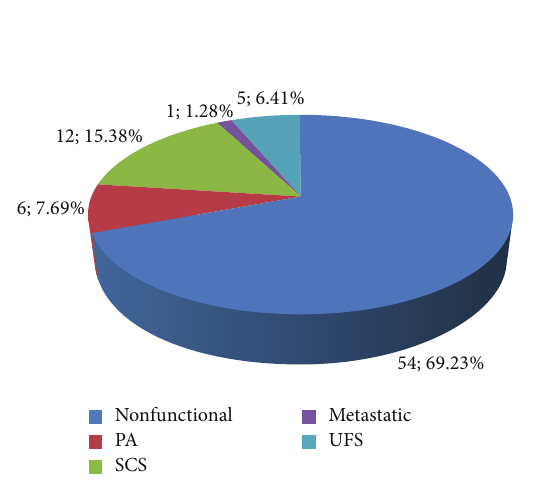
Figure 2: Functional status of patients with incidental adrenal enlargement. SCS: subclinical Cushing syndrome; PA: primary hyperaldosteronism; UFS: unknown functional